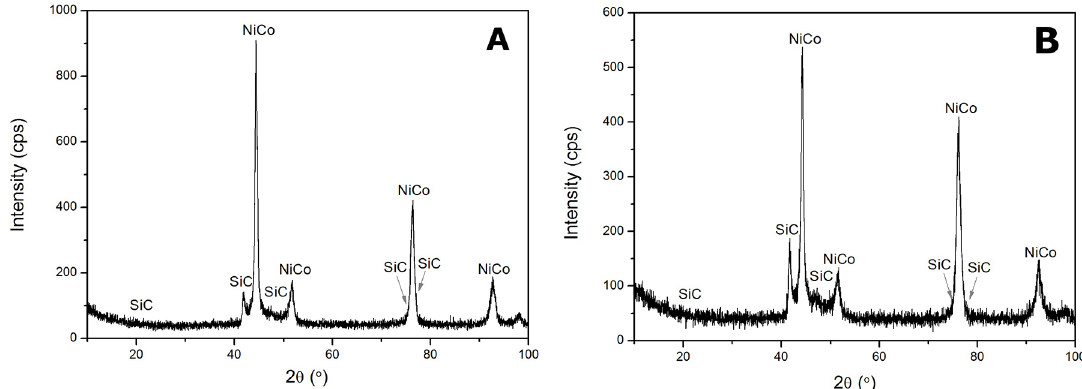
Figure 3. XRD diffractogram of Co-Ni/SiC composite coating. A) 2 A dm -2 and B) 5 A dm -2 . phase solution, which is rich in NiCo, has been formed and identified. The diffractograms illustrate that the matrix of the composite coating is composed of a solid solution of Ni-Co with a face-centered cubic (FCC) crystalline structure, with preferred orientation of the plane (220) followed by (111), (311) and (200). These planes correspond to the respective values of : 44.46 o ; 76.26 o ; 92.62 o e 51.60 o . The change